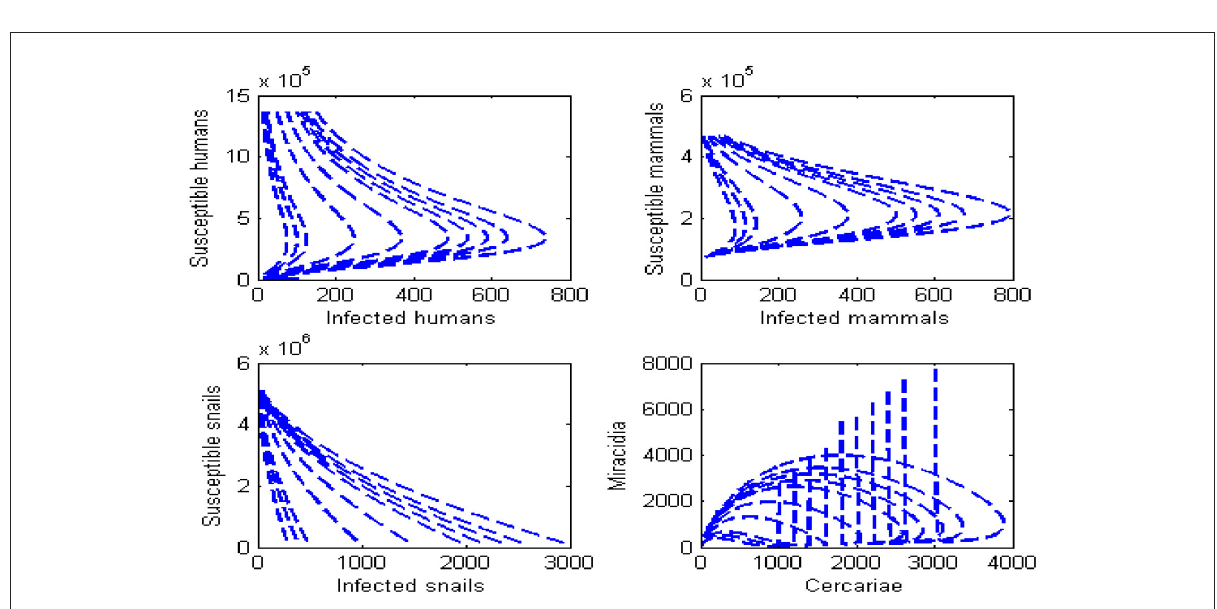
FIGURE8 Phase portraits for the dynamics of Schistosomiasis infection when R 0 > 1. All other parameters in Table